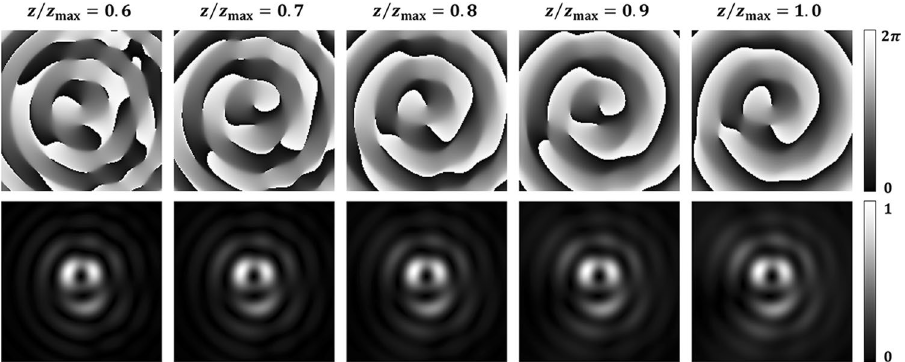
Figure 2. Numerically calculated phase and intensity profiles of a fractional BG beam at different positions. Propagation distance normalized to the non-diffracting distance is displayed on the top of the figure, and used parameters are as follows: w = 2.1 mm , (cid:31) = 594 nm , k r = 7.10 , and l = 1.54